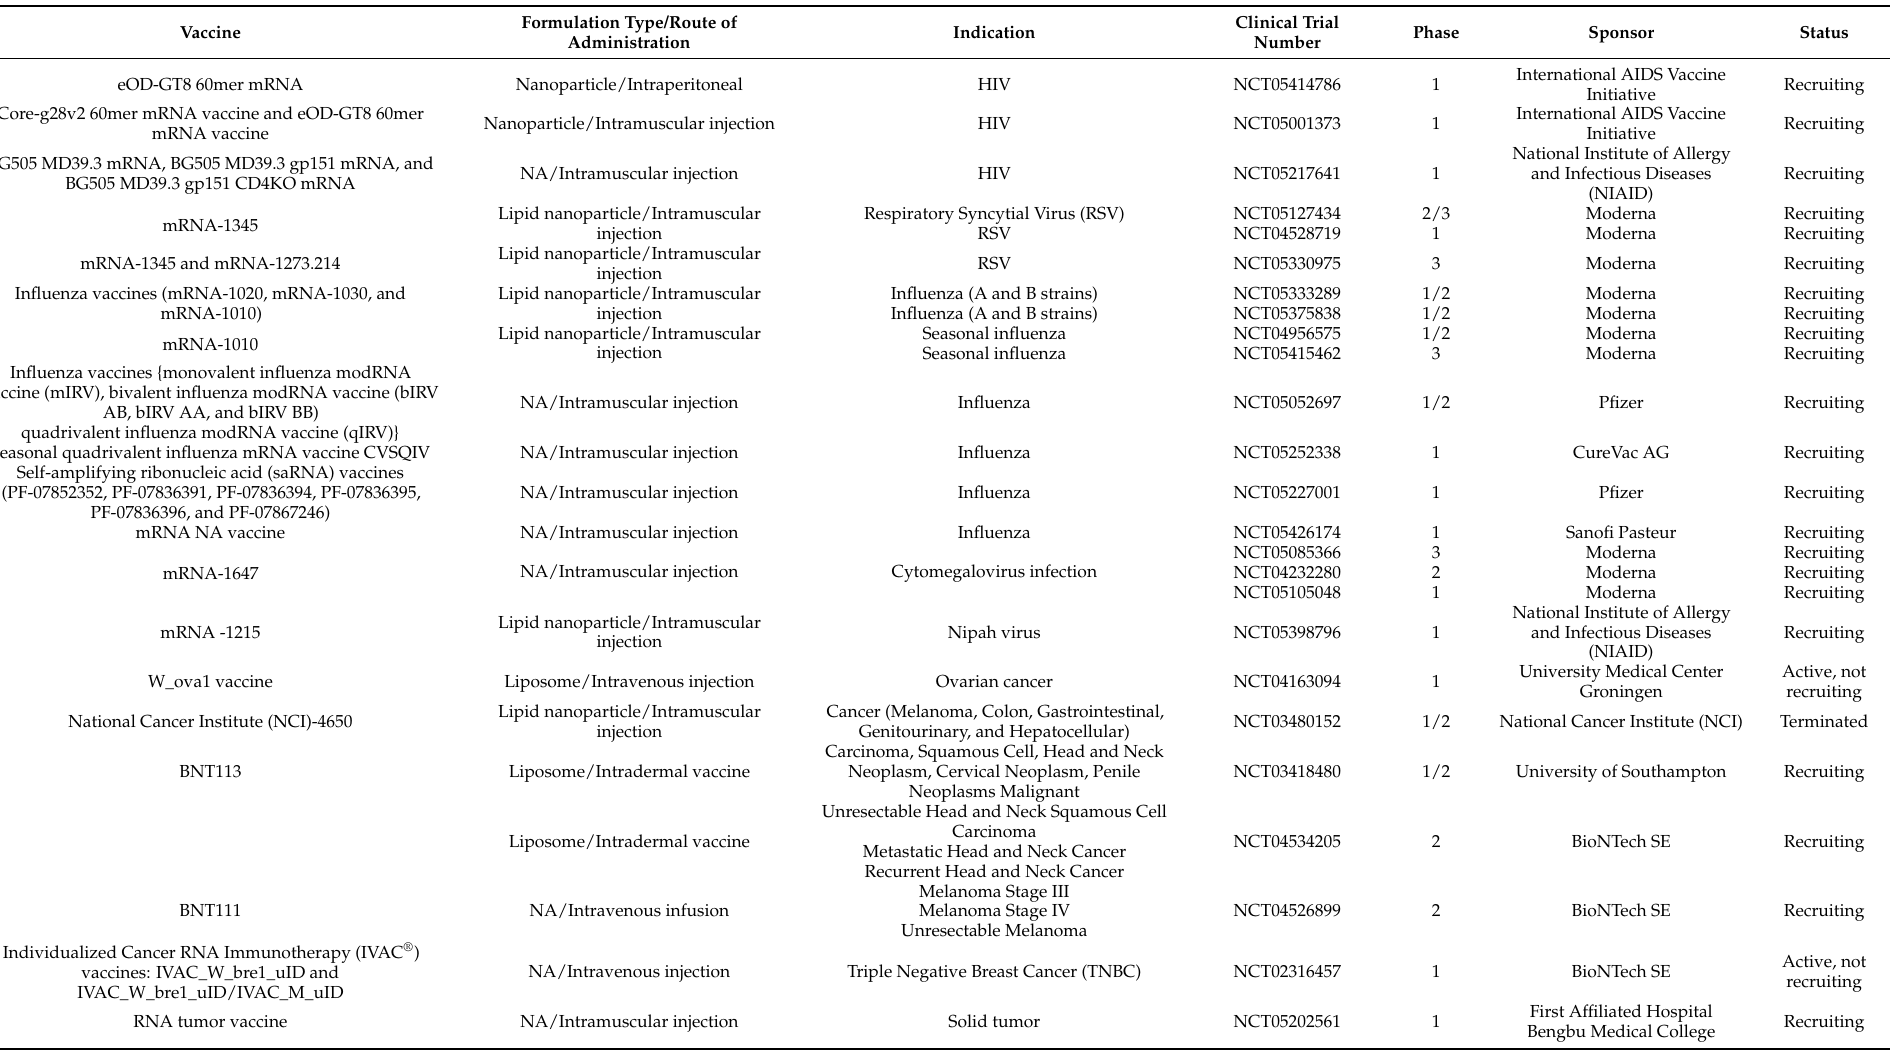
Table 1. Ongoing Clinical Trials With mRNA Vaccines (Excluding COVID-19